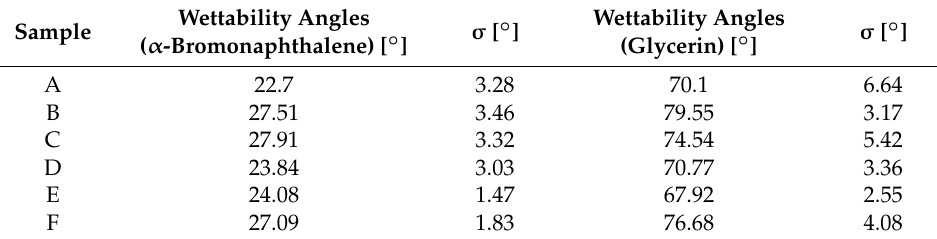
Table 8. Contact angles for α -bromonaphthalene and glycerin.